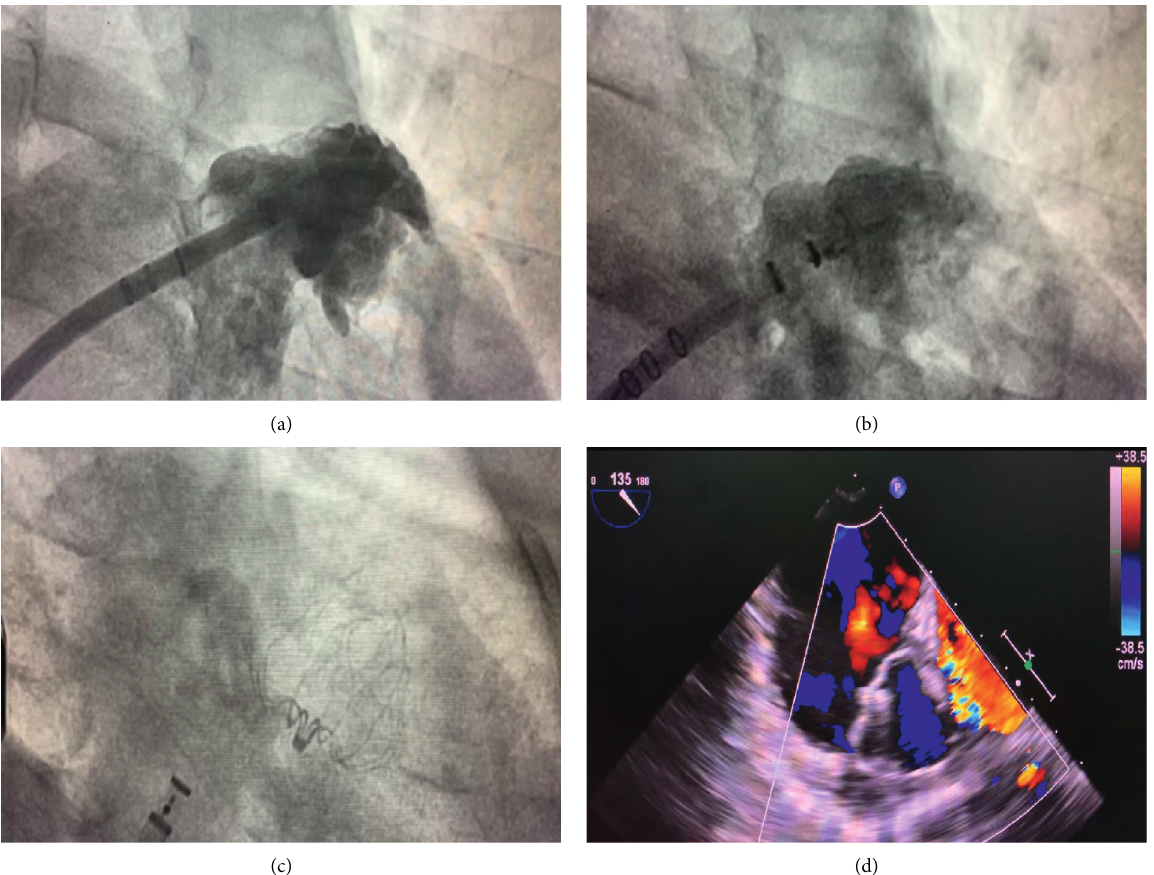
Figure 2: Left atrial appendage closure after catheter ablation with WATCHMAN device. (a) Left atrial appendage angiograph. (b, c) Fluoroscopic view after delivery of the WATCHMAN device; (d) peridevice leakage and compression were detected by TEE